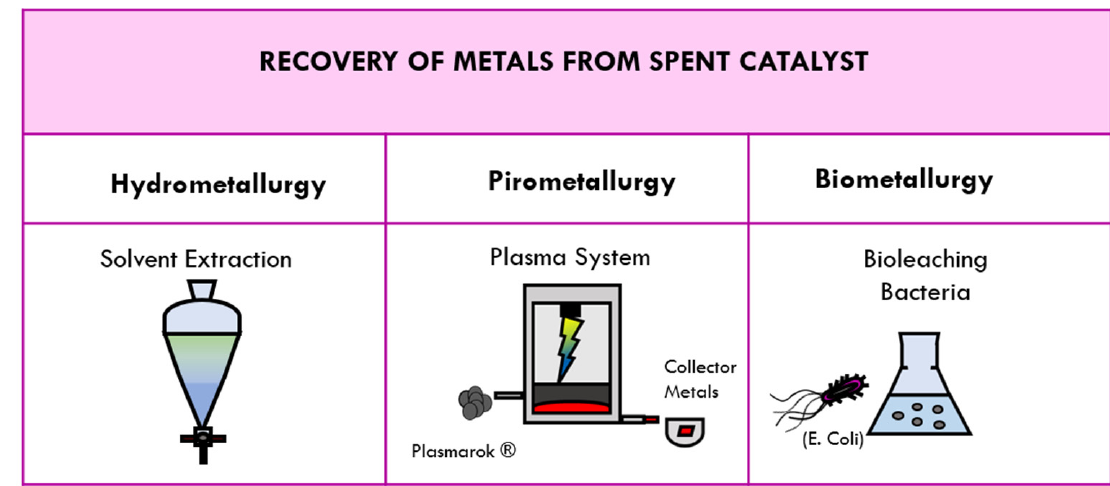
Figure 6. Methods of recovery of metals from spent catalysts: pyrometallurgy, hydrometallurgy, and biometallurgy.